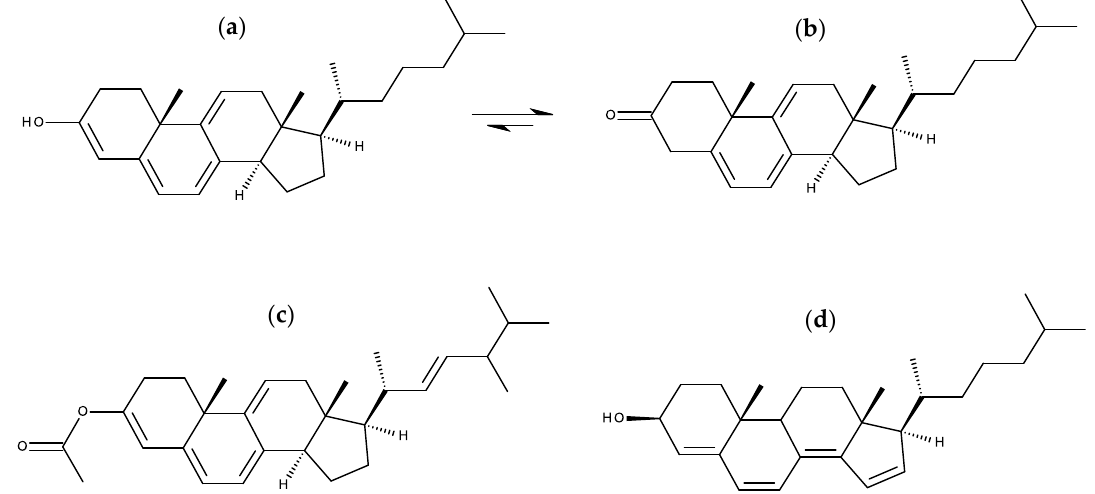
Figure 13. Structures of intrinsically fluorescent design tetraene sterols. ( a ) C4P (enol form); ( b ) C4P (keto form); ( c ) E4Pac; ( d ) unnamed promising tetraene sterol, which does not undergo enol-keto tautomerization [154].